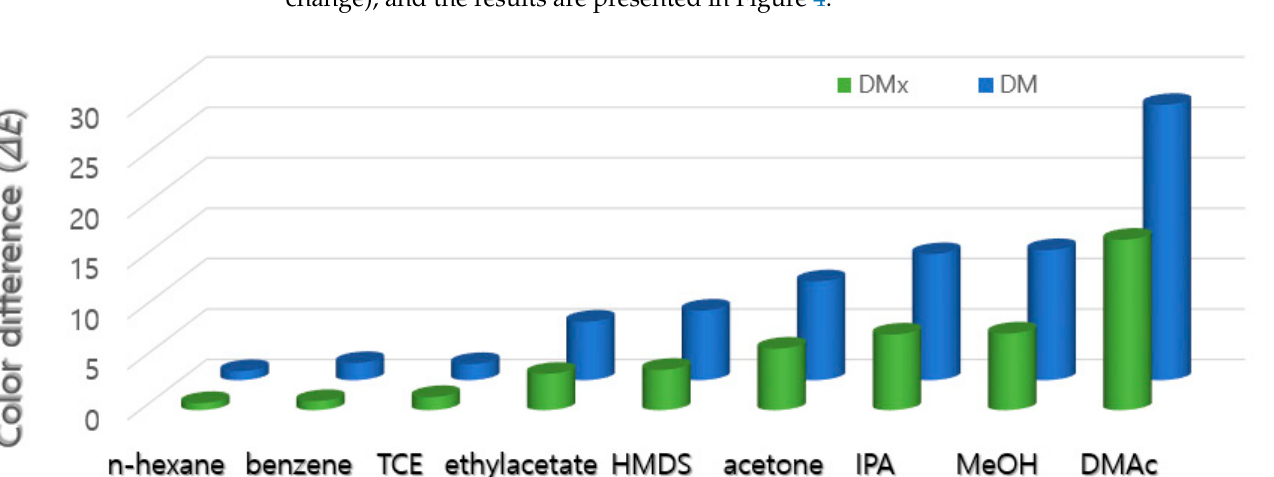
Figure 4. Color differences ( ∆ E ) in cellulosic fabrics dyed with DMx and DM before and after exposure to semiconductor processing solvents.